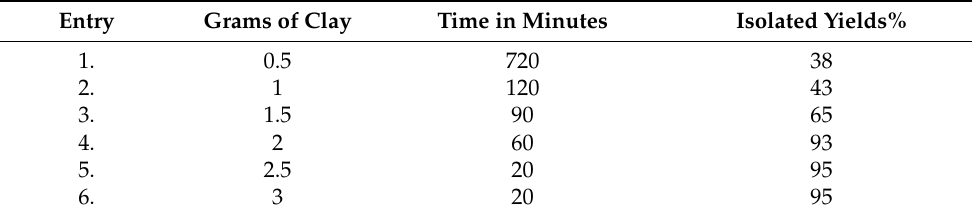
Scheme 1. Synthesis of 2,3-diphenylquinoxaline ( 3 ) with reagents and conditions: ( a ) bentonite clay K-10/EtOH/RT/20 min. K-10/EtOH/RT/20 min. Table 1. The condensation of benzene-1,2-diamine (1 mmol) with benzyl (1 mmol) in the presence of various quantities of bentonite clay K-10 in ethanol (20 mL) at room Table 2. The effects of different solvents on the reaction of benzene-1,2-diamine with benzil in the presence of bentonite clay K-10 at room temperature.